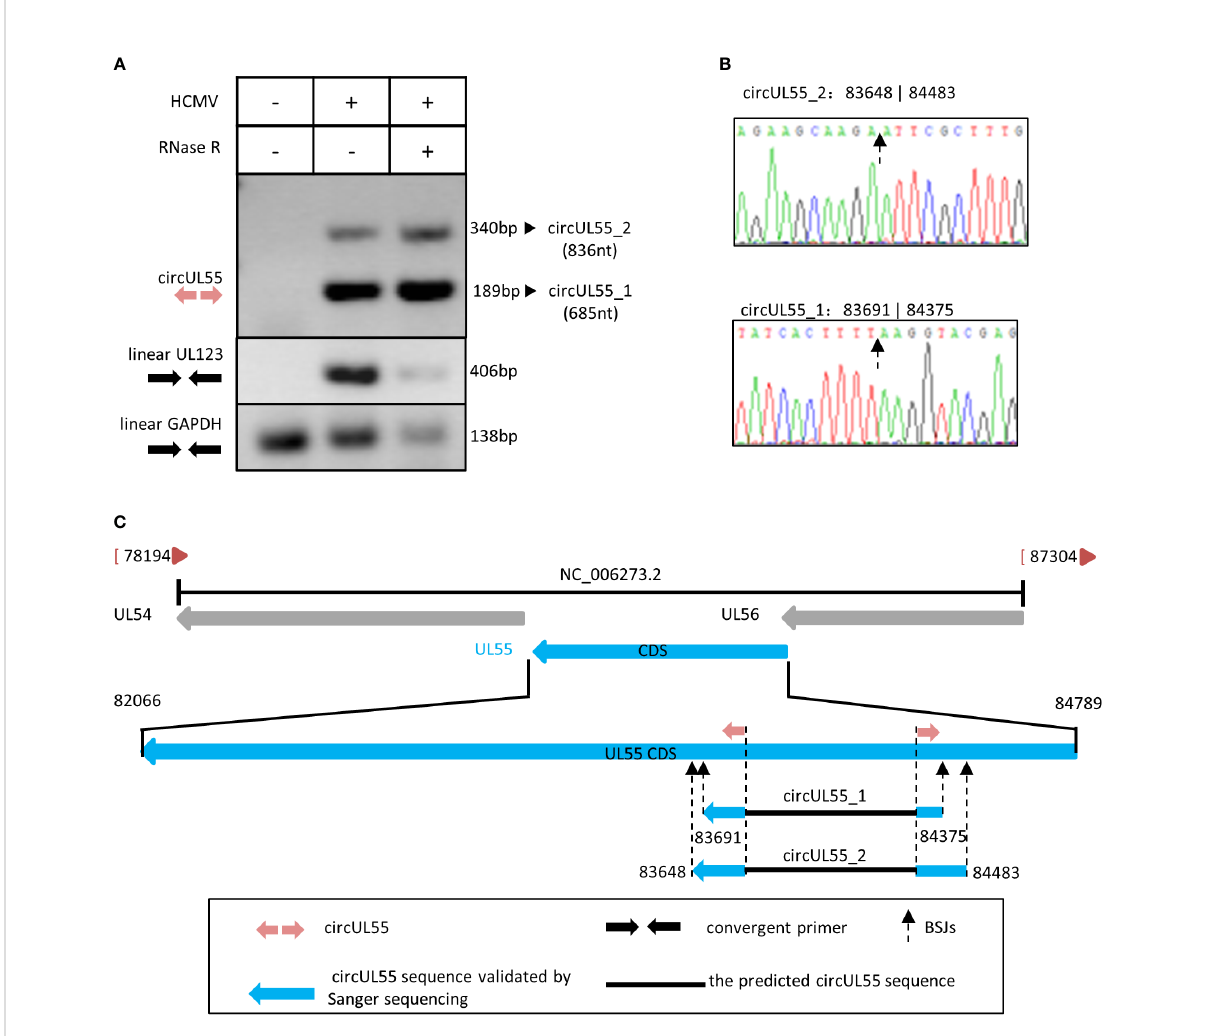
FIGURE 4 Validation and characterization of HCMV circUL55. (A) Inverse RT-PCR products of circUL55 with BSJs validation primer set in Figure 1. The 189 bp band that ampli fi ed from circUL55_1 (685 nt) was the predicted amplicon of the primer. A 340 bp band from circUL55_2 (836 nt) was ampli fi ed. Linear GAPDH and linear UL123 were ampli fi ed as RNase R-resistant control. (B) Sanger sequencing result of circUL55_1 and circUL55_2 BSJs. (C) Isoforms of circUL55mapping to HCMV UL55